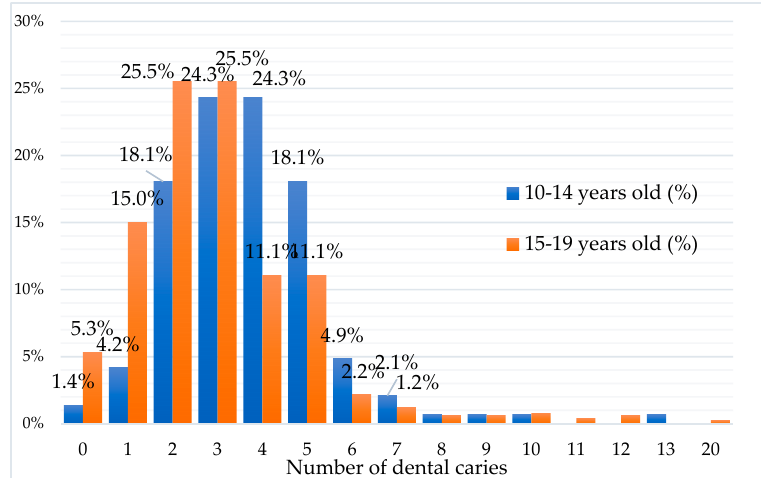
Figure 2. Percentages of adolescents with decayed, missing, or filled teeth by age sub ‐ group and the number of caries.